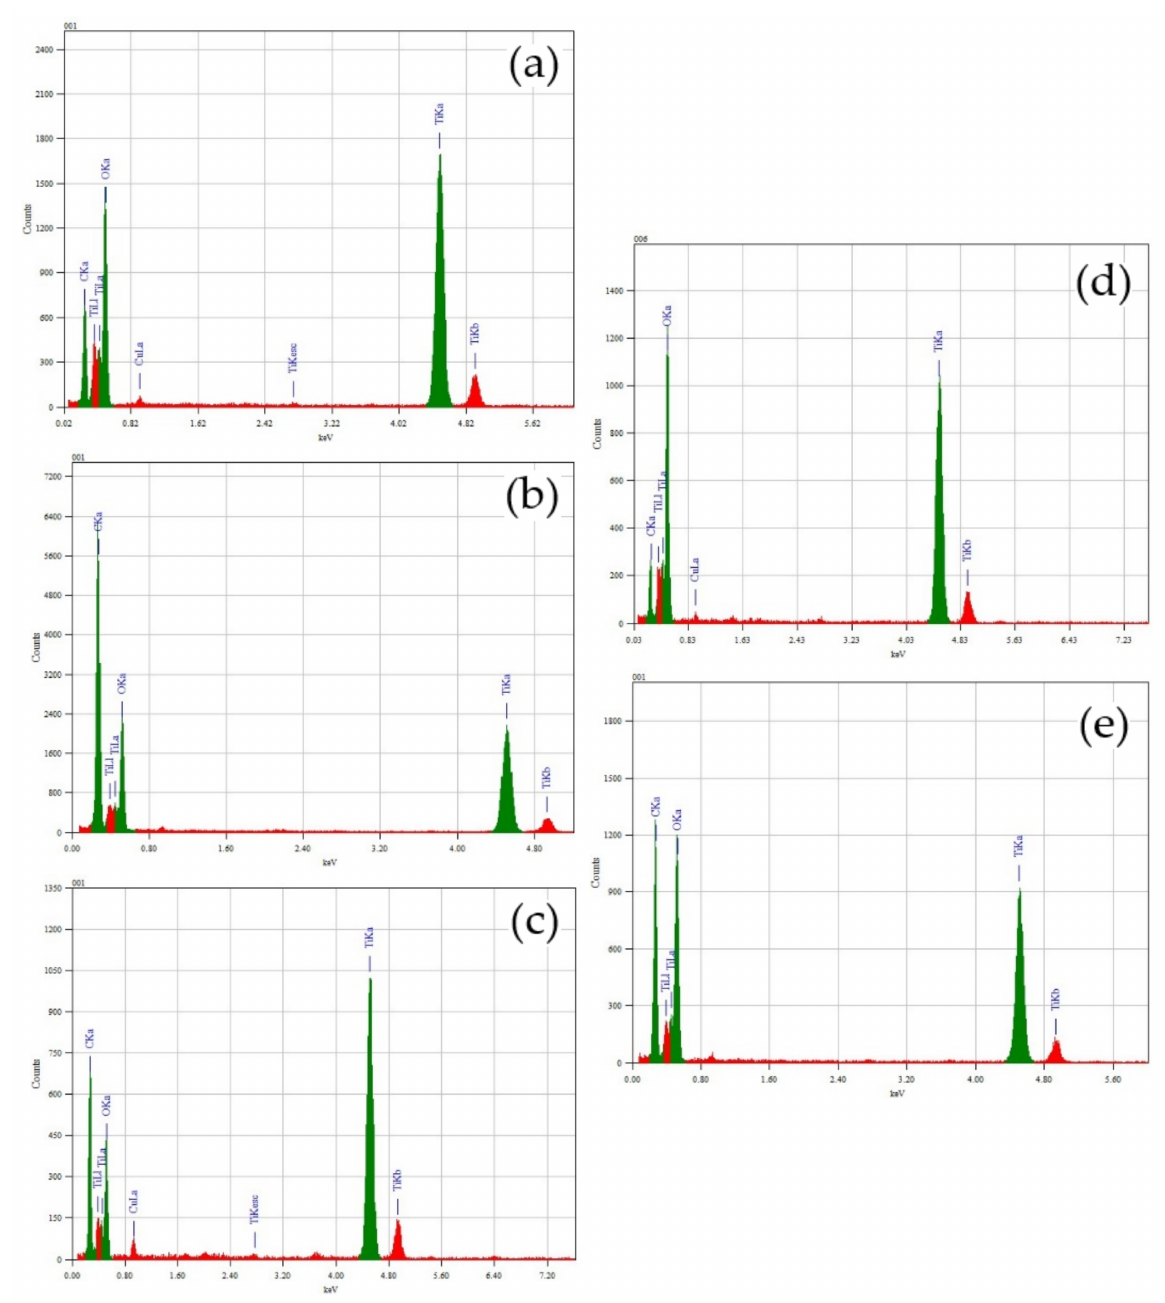
Figure A4. EDS of the TEM analysis showing Ti and O presence in the detected nanoparticles: ( a ) Chihuahua South Summer; ( b ) Chihuahua South Spring; ( c ) Casas Grandes Spring; ( d ) Chihuahua North Spring; and ( e ) Juarez